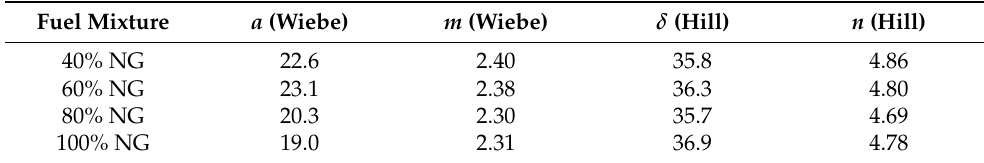
Table 3. Average calibration coefficients for all the fuel mixtures.